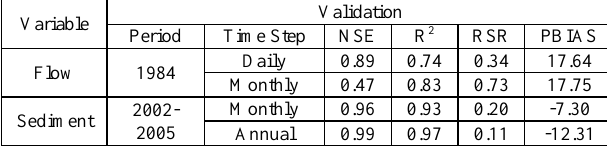
Table 5. Model Performance during validation.